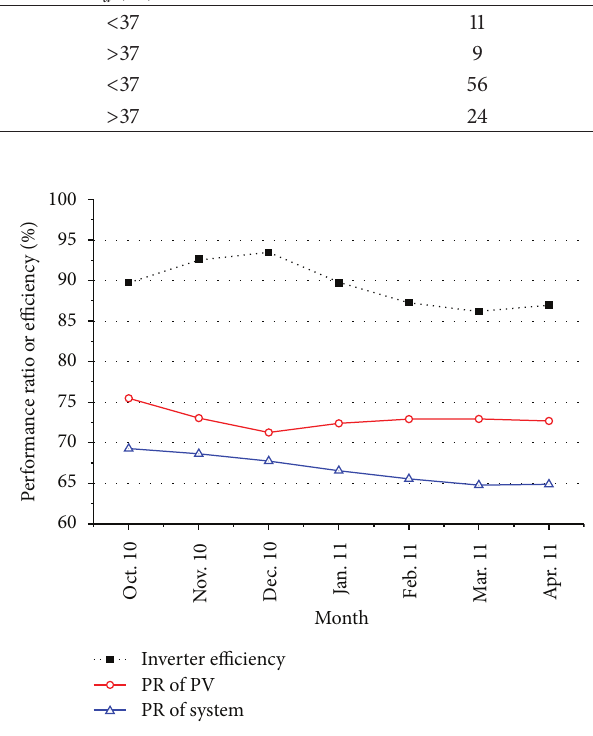
Figure 6: Trends of monthly solar energy received ( 𝐸 𝑟 ) and average ambient temperature ( 𝑇 𝑎 ). Figure 7: Trends of monthly inverter efficiency, PR of PV modules, and PR of PV system.